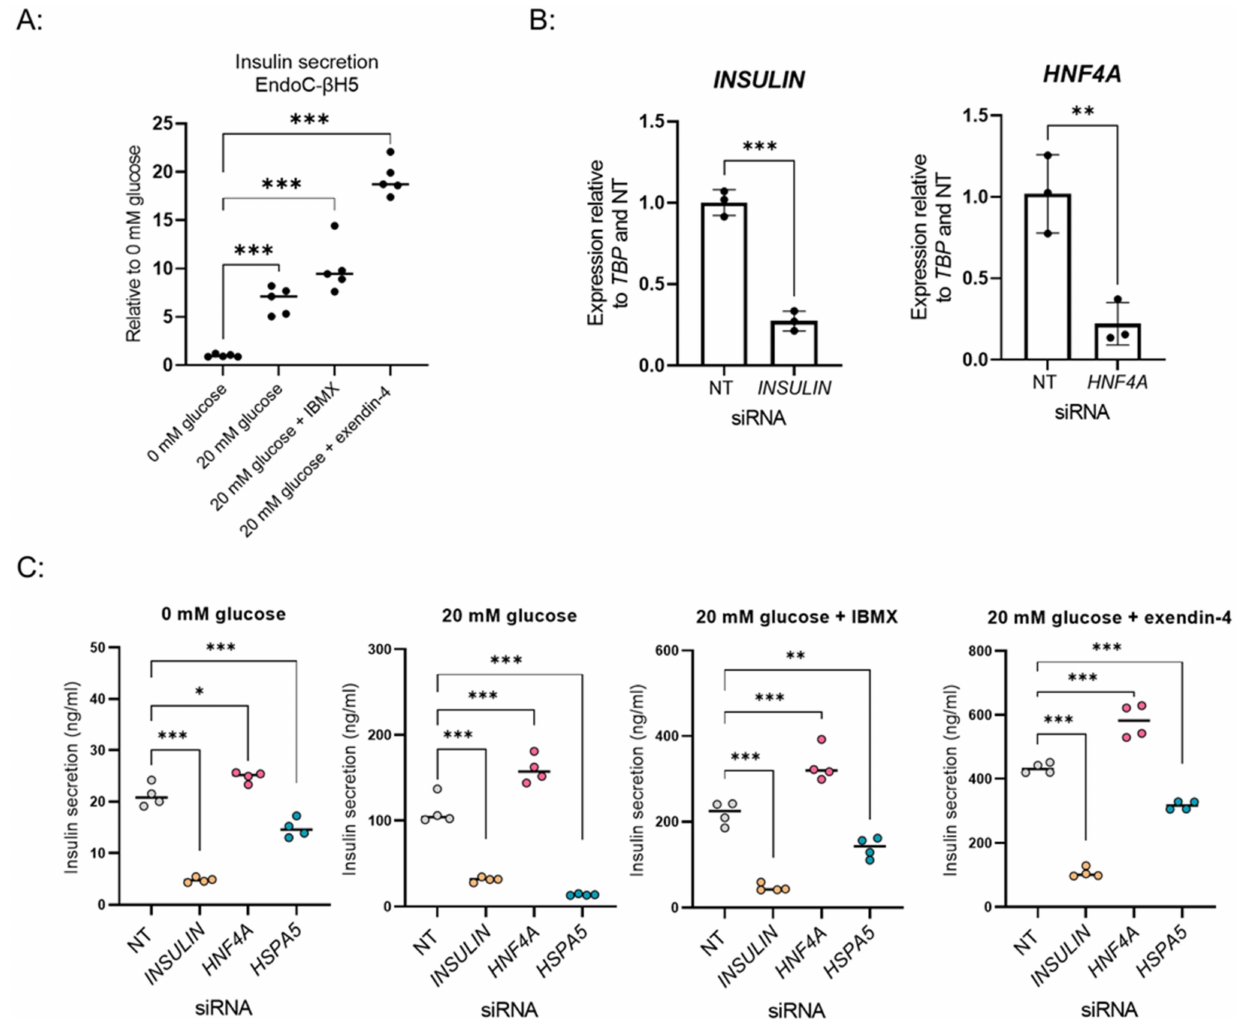
Figure 4. EndoC- β H5 cells can be adapted to siRNA screen. ( A ) GSIS assay in EndoC- β H5 cells cultured in 384-well format. Data points are the mean ± SD of independent wells ( n = 5) from one experiment for 0 mM glucose, 20 mM glucose, 20 mM glucose + IBMX, and 20 mM glucose + exendin- 4. *** p -value < 0.001, one-way ANOVA. ( B ) Relative expression of INSULIN and HNF4A after knockdown with respective siRNAs in EndoC- β H5 cells in 384-well format. Data points are the mean ± SD of independent wells ( n = 3) from one experiment. ** p -value < 0.01, *** p -value < 0.001, t -test. ( C ) Knockdown effect of INSULIN, HNF4A and HSPA5 on GSIS in EndoC- β H5 cells. Data points are the mean ± SD of independent wells ( n = 4) from one experiment for 0 mM glucose, 20 mM glucose, 20 mM glucose + IBMX and 20 mM glucose + exendin-4. * p -value < 0.05, ** p -value < 0.01, *** p -value < 0.001, one-way